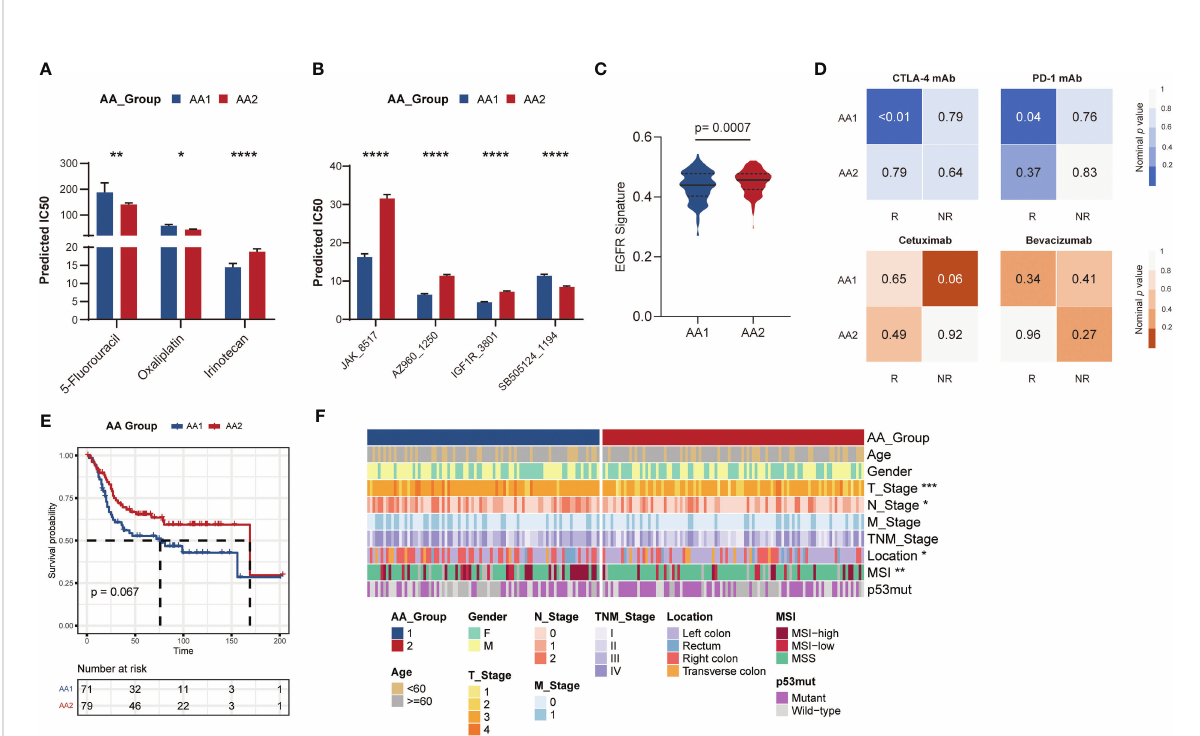
FIGURE 5 Correlation of the AA subtypes with treatment prognosis. Generation and validation of the AA classi fi er in the GEO dataset. (A) Bar chart of the predicted IC50 of COAD chemotherapy drugs 5- fl uorouracil, oxaliplatin, and irinotecan of two AA subtypes. (Mann-Whitney Wilcoxon test). (B) Bar chart of the predicted IC50 of JAK inhibitor (JAK_8517 and AZ960_1250), IGF1R inhibitor (IGF1R_3801), and TGF b /SMAD4 receptor inhibitor (SB505124_1194) of two AA subtypes. (Mann-Whitney Wilcoxon test) (C) EGFR signatures in two subtypes. (Mann-Whitney Wilcoxon test) (D) SubMap analysis for immunotherapy prediction in melanoma cohort (upper) and the response of targeted therapy cetuximab and bevacizumab in colorectal cancer cohort (bottom). (E) Overall survival of two AA subtypes typed by 60-gene classi fi er in GSE41258 cohort. (Log-rank test) (F) Clinical and pathological characteristics of the two subtypes in the GSE41258 cohort. * P <0.05, ** P < 0.01, *** P < 0.001, **** P <